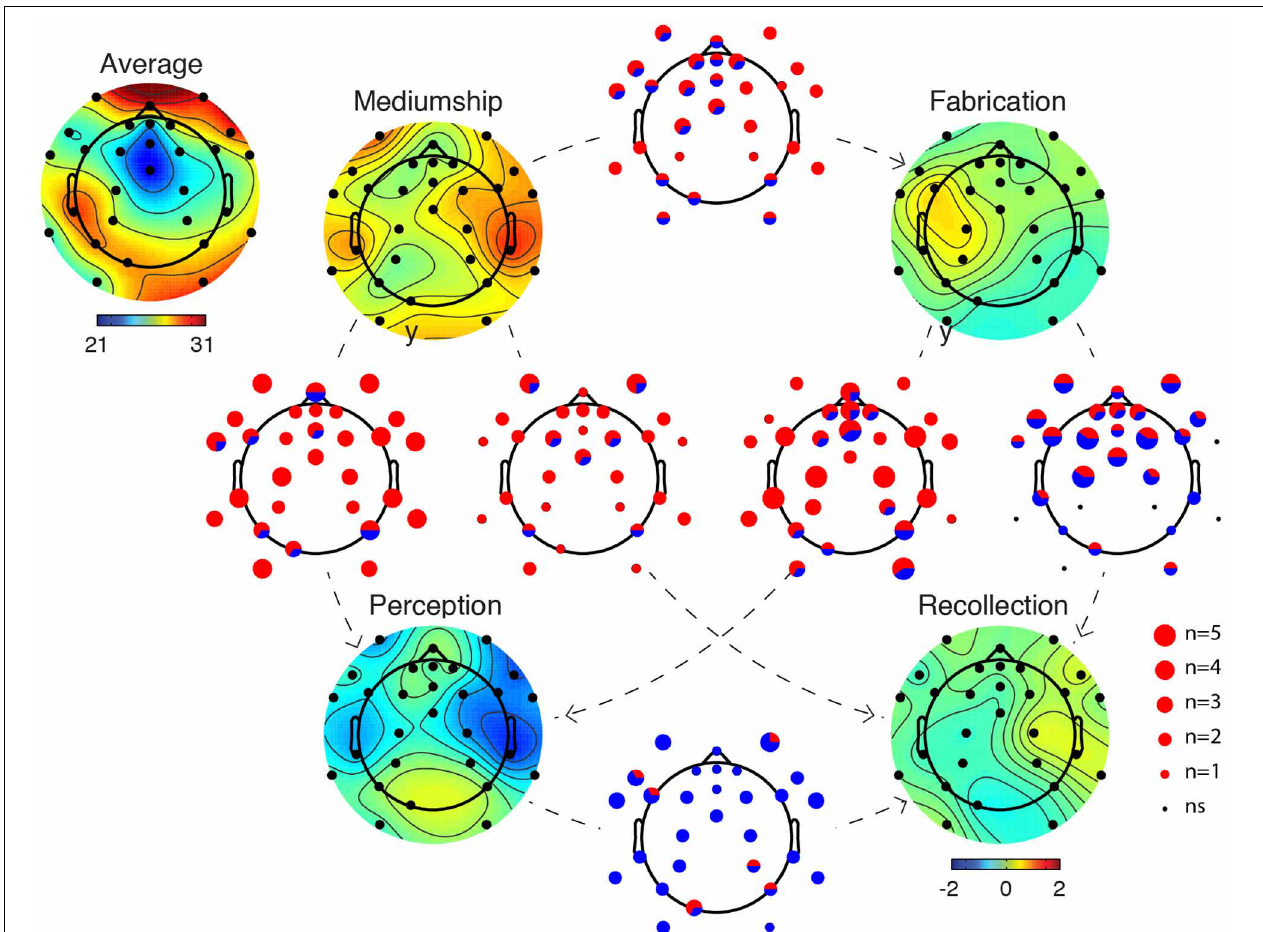
FIGURE 3 | Summary figures depicting differences between mental states in the high gamma frequency band (75–110Hz). The scalp topography image in the left upper corner indicates the average gamma power for all mental states and all subjects [the unit being 10 ∗ log 10 ( µ V 2 )]. Scalp topographies for each mental state indicate deviation from the average scalp power (same units). In between each pair of mental states A and B, a plot indicates the number of significant participants for each electrode ( p < 0 . 01 after cluster correction for multiple comparisons). The size of the dot represents the number of participants for which a given electrode is